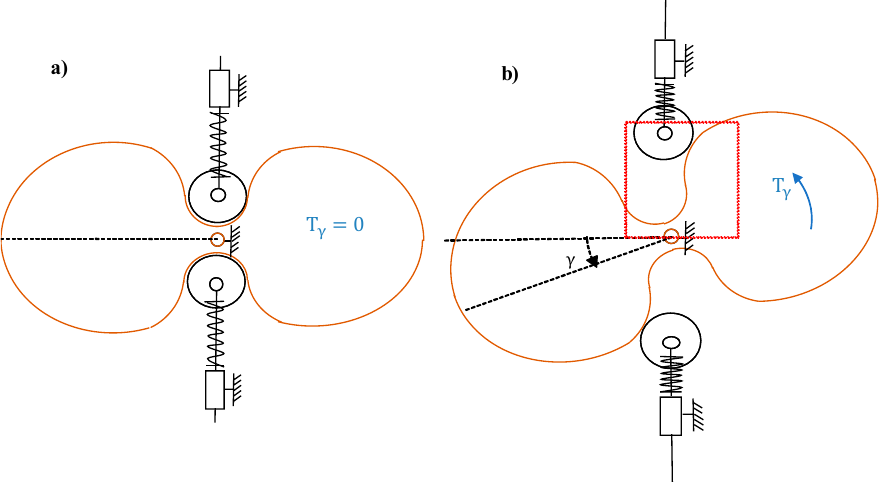
ff ness generator block: ( a ) at rest γ = 0 ( T γ = 0); ( b ) at deflection γ (cid:44) 0 ( T γ Figure 4. Stiffness generator block: ( a ) at rest 𝛾 = 0 ( 𝑇 (cid:3082) = 0); ( b ) at deflection 𝛾 ≠ 0 ( 𝑇 (cid:3082) ). Figure 4. Sti